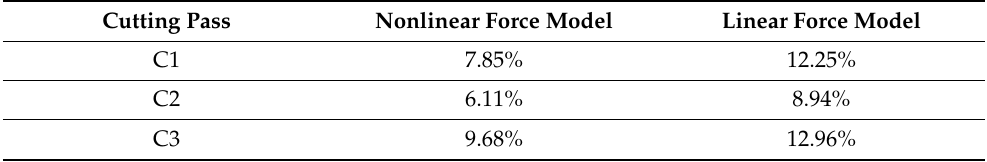
Table 5. The error of cutting force prediction.